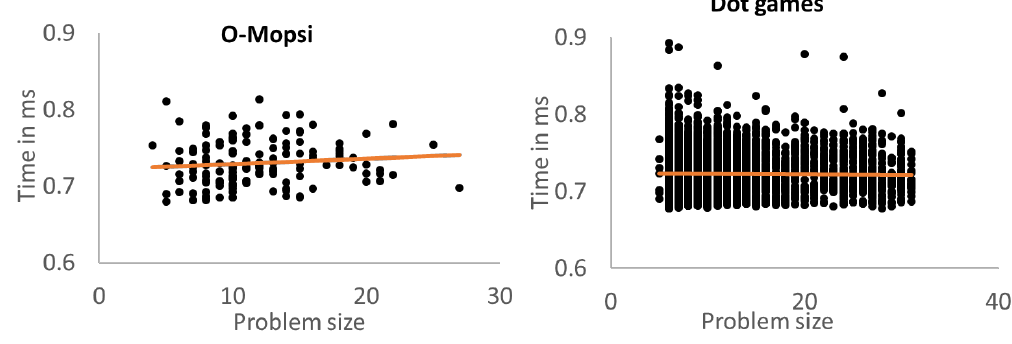
Figure 18. Run time as a function of problem size.